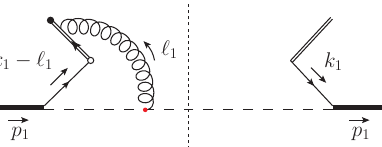
in our model (also the 1